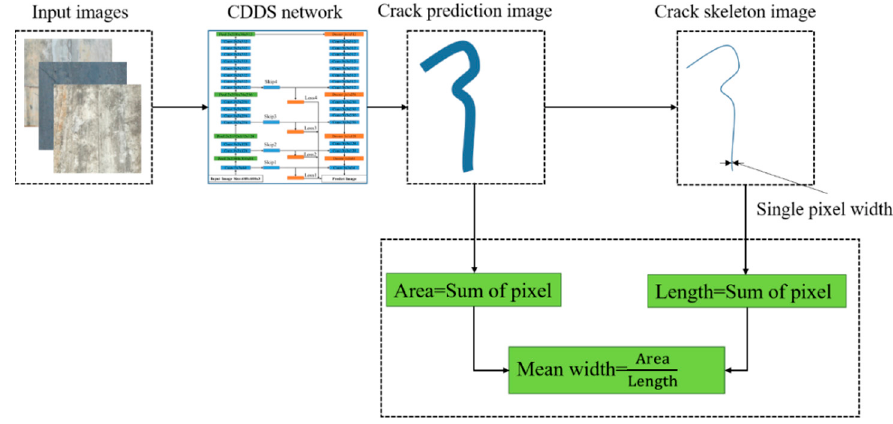
Figure 12. Schematic diagram of the size of the crack calculation process.